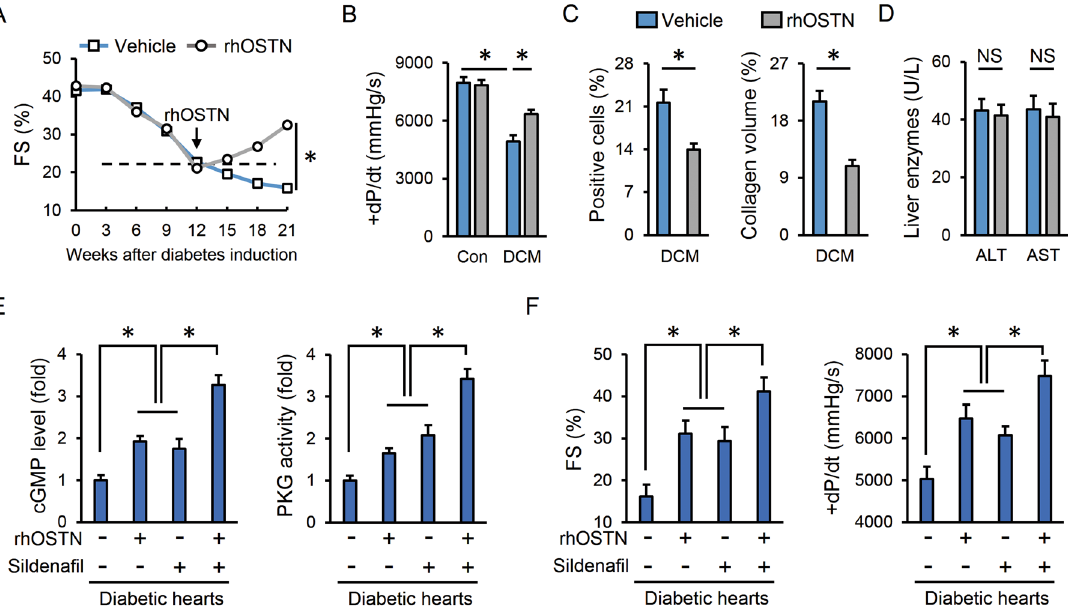
Fig. 6 OSTN is a promising therapeutic target to treat DCM. A , B Cardiac functional parameters ( n = 8). C Statistical results of the TUNEL- positive nuclei and collagen deposition ( n = 6). D Serum levels of liver enzymes ( n = 6). E Relative cGMP levels and PKG activities in heart samples ( n = 6). F Cardiac functional parameters ( n = 6). Data represent mean ± SD. * P < 0.05 versus the matched group, NS indicates no signi fi